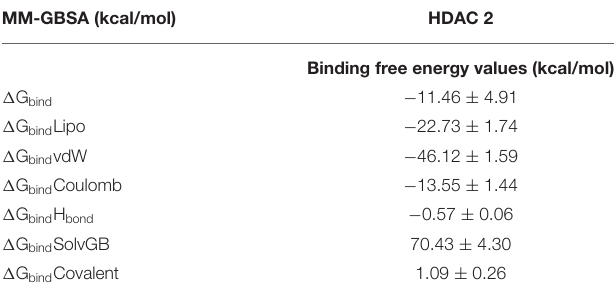
TABLE 2 | Binding free energy components for the docking complexes of HDAC 2 protein with ligand cinnamyl dihydrocinnamate (CMNPD5348) calculated by MM-GBSA